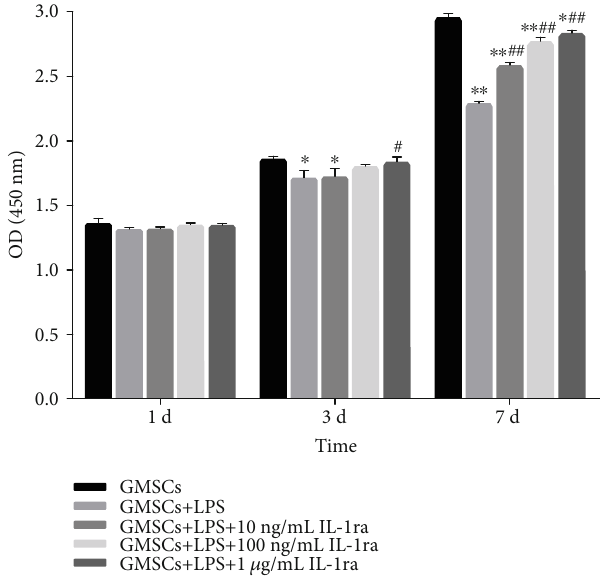
Figure 5: E ff ect of P. gingivalis -LPS and IL-1ra on rGMSC proliferation potential at 1, 3, and 7 days. ∗ P < 0 : 05 , ∗∗ P < 0 : 01